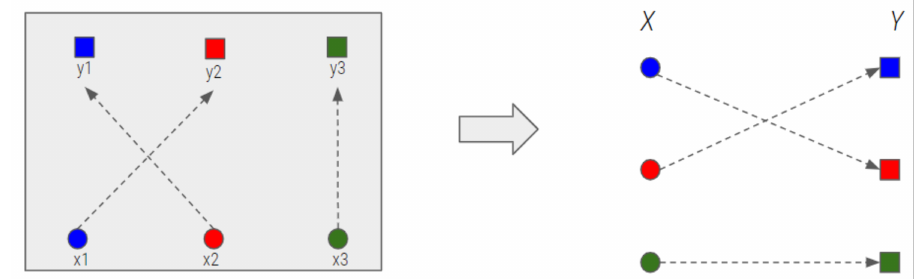
Figure 10. Scene transition (left: based on spatial coordinates, right: based on a bipartite